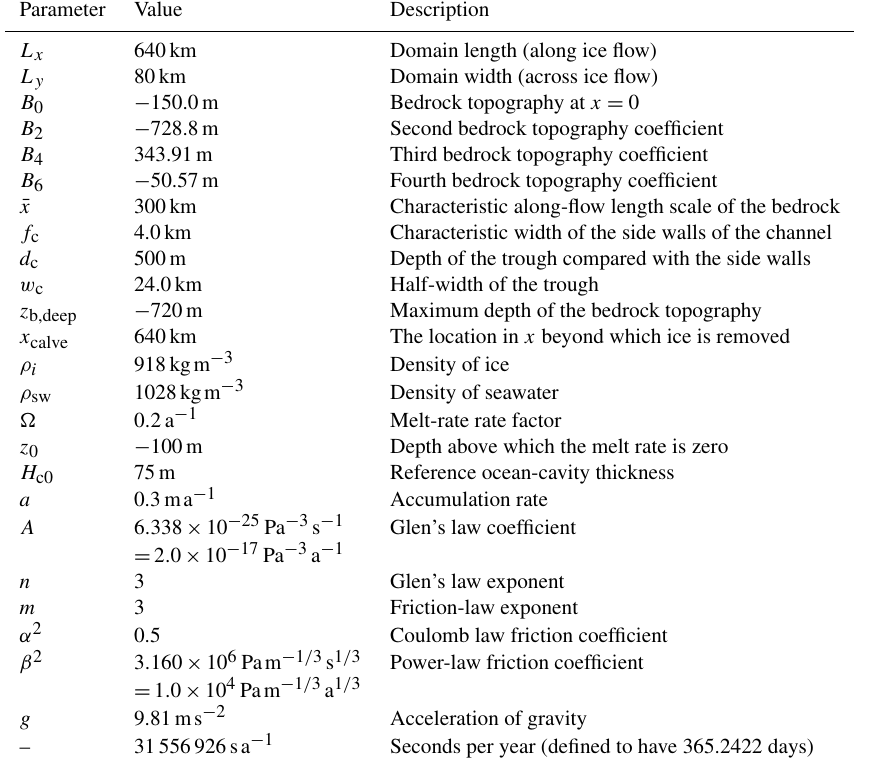
Table 1. Parameters for the MISMIP + experiments. Parameter Value Description 640km Domain length (along ice flow)